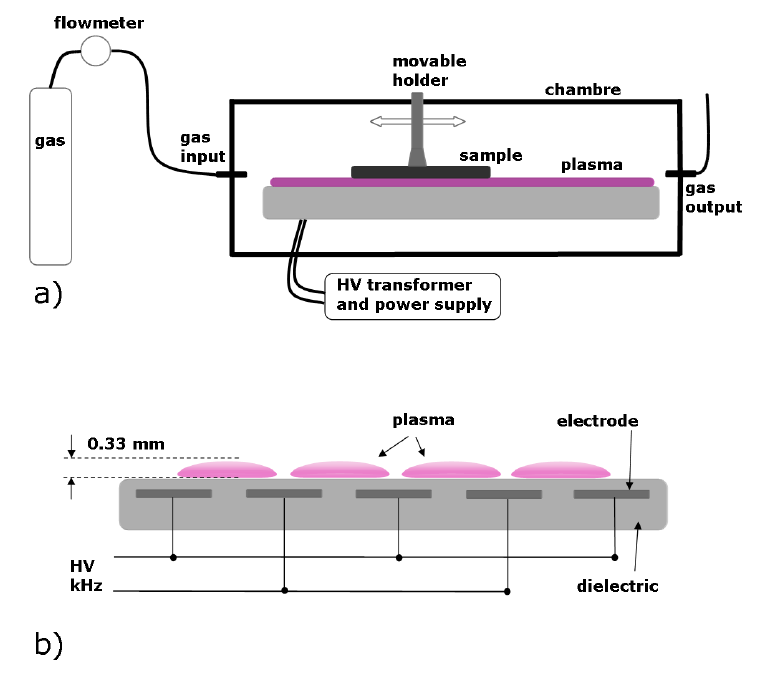
Figure 1 : The schematic of a) DCSBD reactor and b) cross-section of an electrode